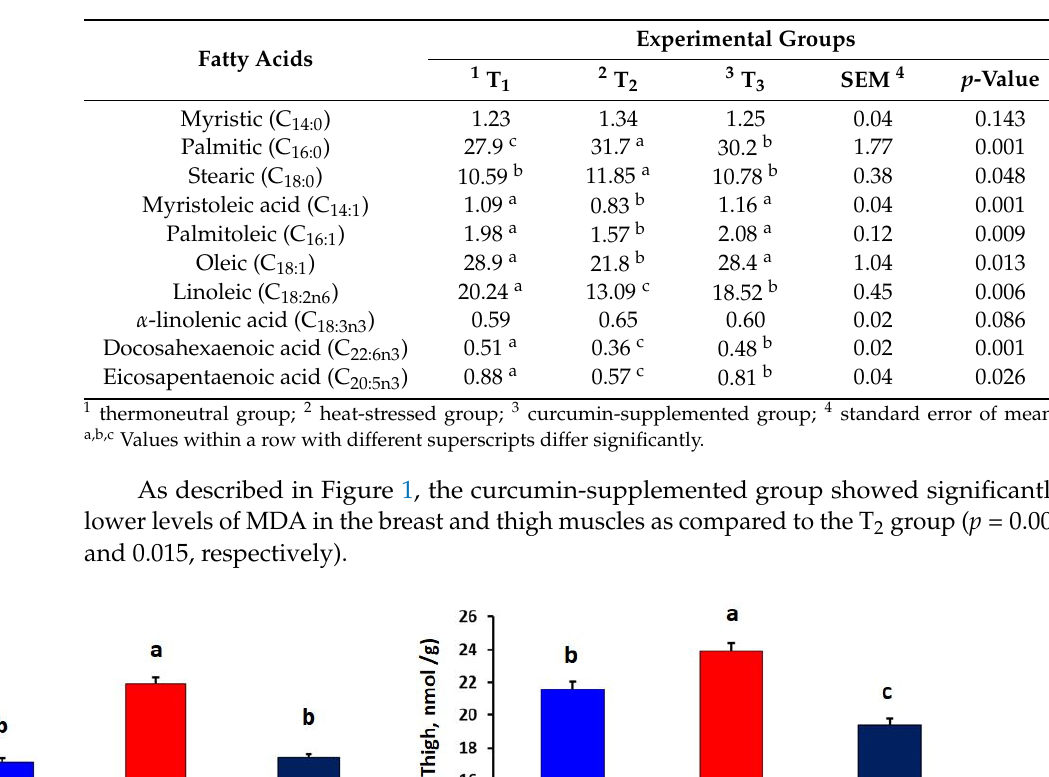
Table 4. Effect of dietary curcumin supplementation on fatty acid profile (g/100 g) of thigh muscles in heat-stressed broiler chickens.